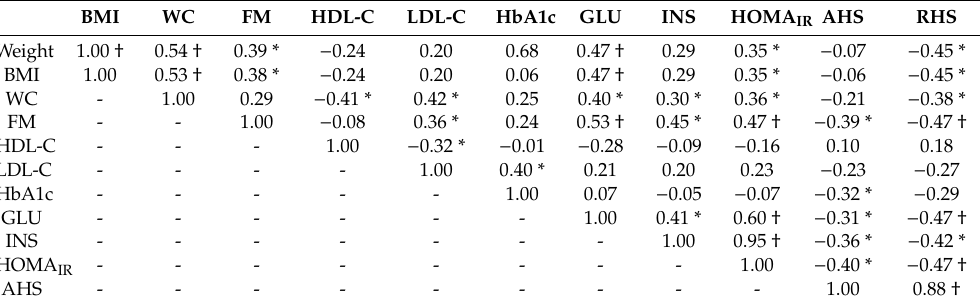
Table 3. Matrix of the correlations between the percentage variations of the variables after